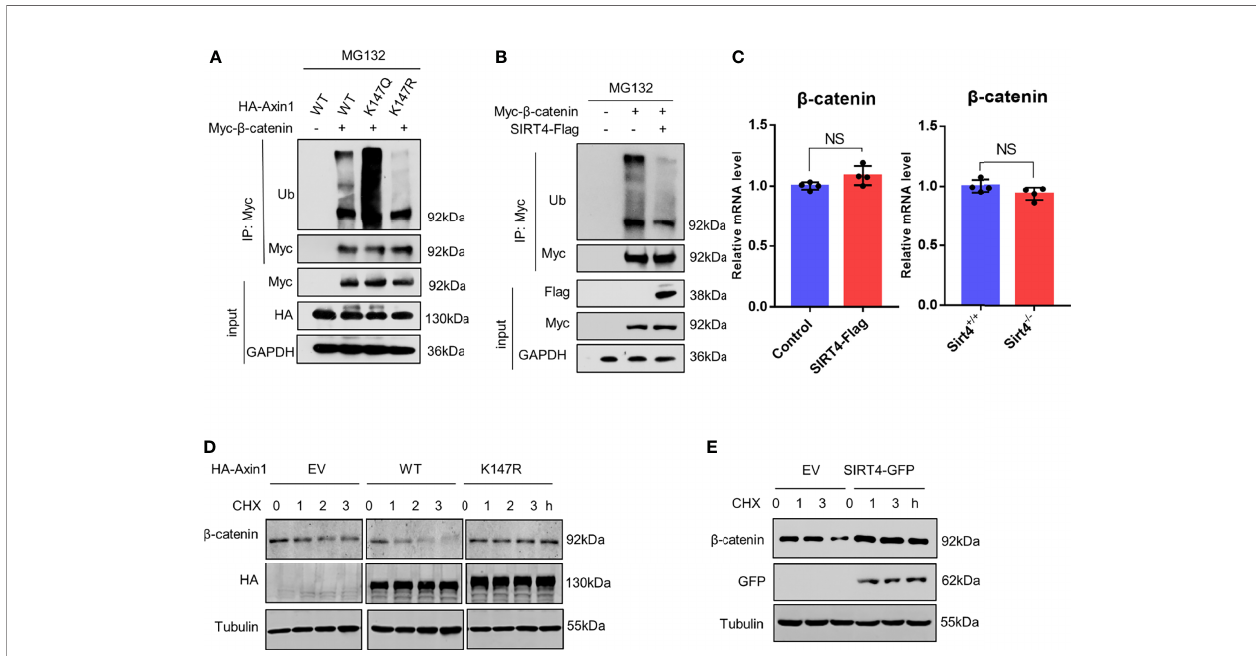
FIGURE 6 | SIRT4 downregulates the ubiquitination of b -catenin. (A) HEK293T cells were cotransfected with Myc- b -catenin and HA-Axin1 (WT, K147Q or K147R) as indicated, the cells were treated with 10 mM MG132 for 4 h, and then whole cell lysates were collected, Myc- b -catenin was immunoprecipitated with anti-Myc. Both whole cell lysates and precipitates were analyzed by western blot with the indicated antibodies. (B) HEK293T cells were cotransfected with Myc- b -catenin and SIRT4-Flag as indicated, the cells were treated with 10 mM MG132 for 4 h, and then whole cell lysates were collected, Myc- b -catenin was immunoprecipitated with anti-Myc. Both whole cell lysates and precipitates were analyzed by western blot with the indicated antibodies. (C) RT – qPCR analysis of the mRNA of b -catenin (CTNNB) in HEK293T cells transfected with SIRT4-Flag. RT – qPCR analysis of the mRNA of b -catenin (CTNNB) in Sirt4 +/+ MEFs or Sirt4 − / − MEFs (n=4, error bars represent ± SD, p=0.08>0.05 in HEK293T cells, p=0.1>0.05 in MEFs cells. NS-not signi fi cant, unpaired, two-tailed, parametric t-test were used). (D) HEK293T cells were transfected with HA-Axin1 (WT or K147R) as indicated, the cells were treated with 1 m M cycloheximide (CHX) for the indicated times. Whole cell lysates were collected and analyzed by western blot with the indicated antibodies. (E) HEK293T cells were transfected with or without SIRT4-GFP as indicated, the cells were treated with 1 m M cycloheximide (CHX) for the indicated times. Whole cell lysates were collected and analyzed by western blot with indicated